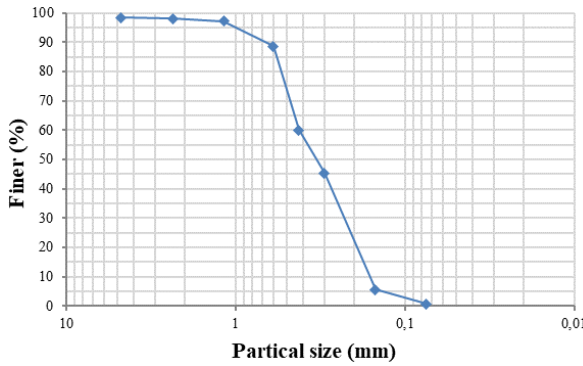
Figure 3: Grain size distribution